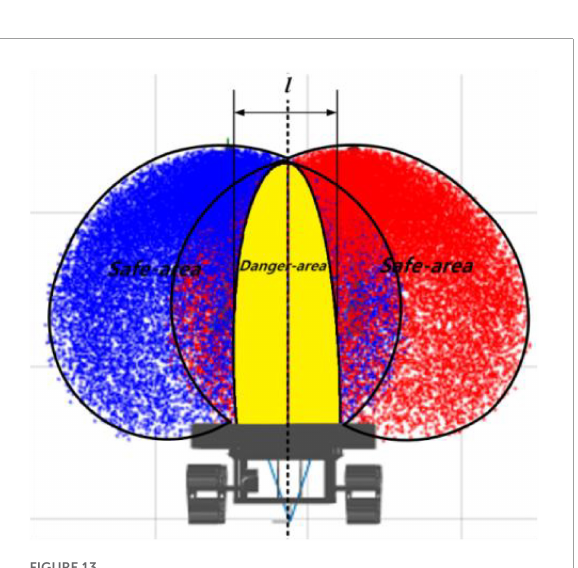
FIGURE13 Danger area and safe area in dual-arm operating space.